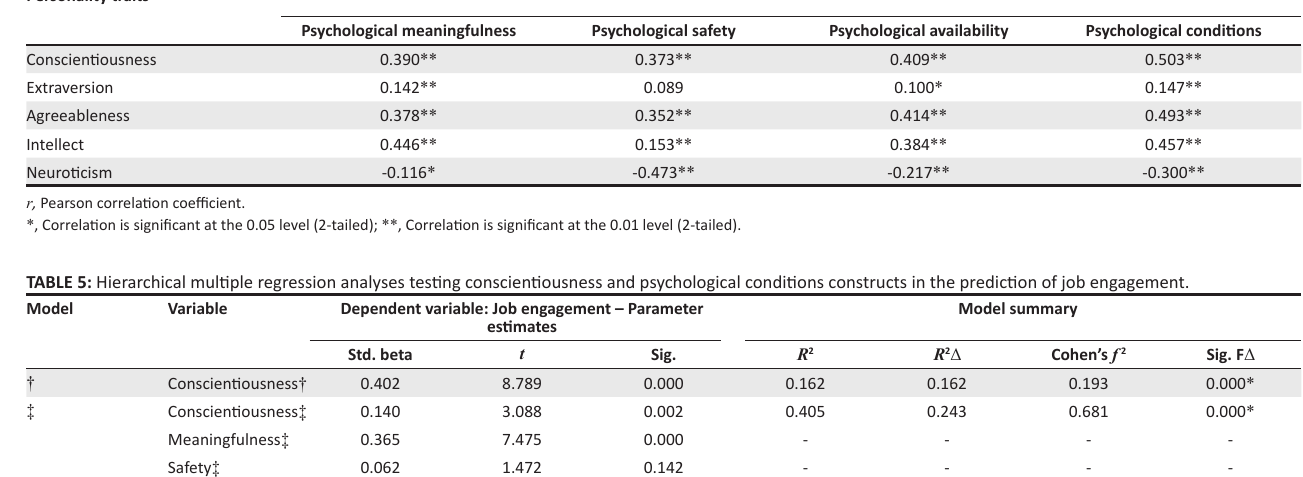
TABLE 4 : Pearson correlation coefficients ( r ) for relations of personality traits and psychological conditions. Personality